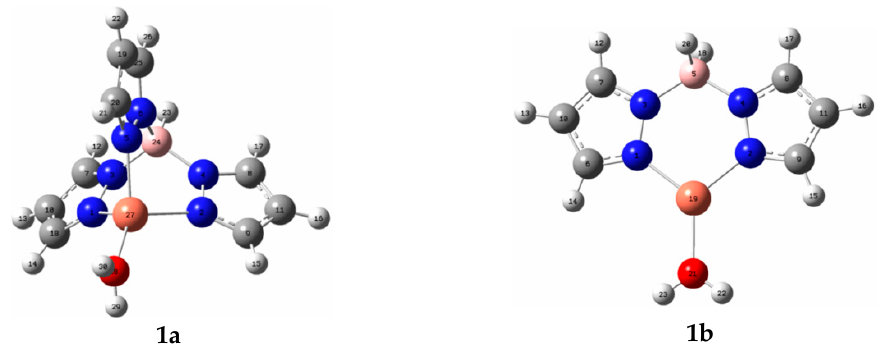
Figure 2. Optimized structures of the complexes 1a and 1b . Table 1. Selected theoretical parameters of the geometry of 1a and 1b and their comparison with the experimental parameters